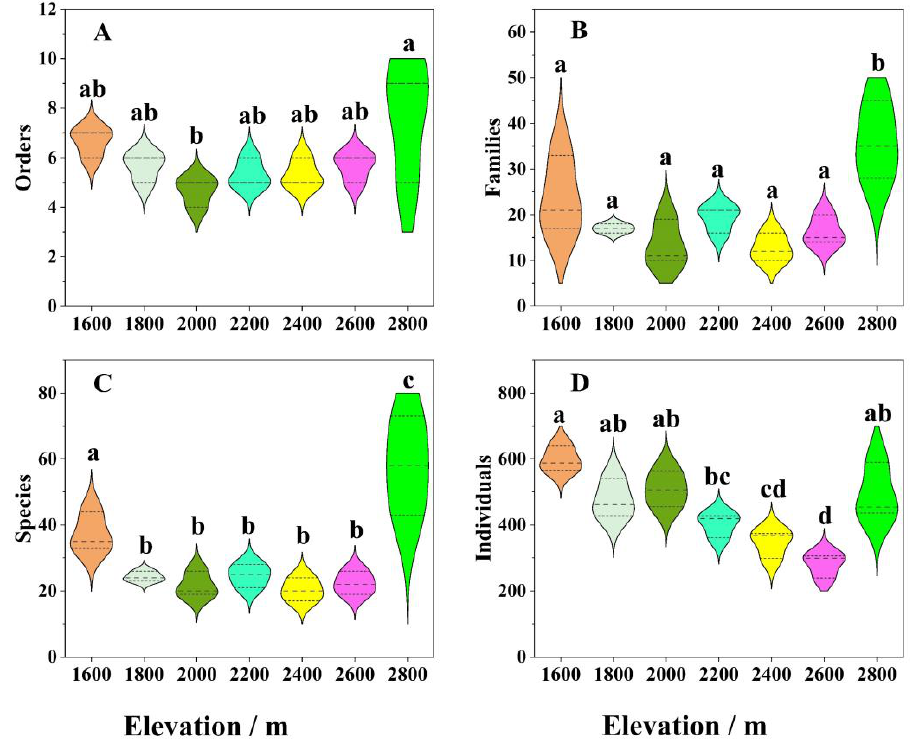
Figure 4. The difference in insect composition in typical vegetation community ecosystems along altitudinal gradient of the Guandi Mountain. ( A ): Orders; ( B ): Families; ( C ): Species; ( D ): Individuals. Note: Values are mean ± SD of three replicates for each typical vegetation community ecosystem. For each column, values with different letters are significantly different at p =